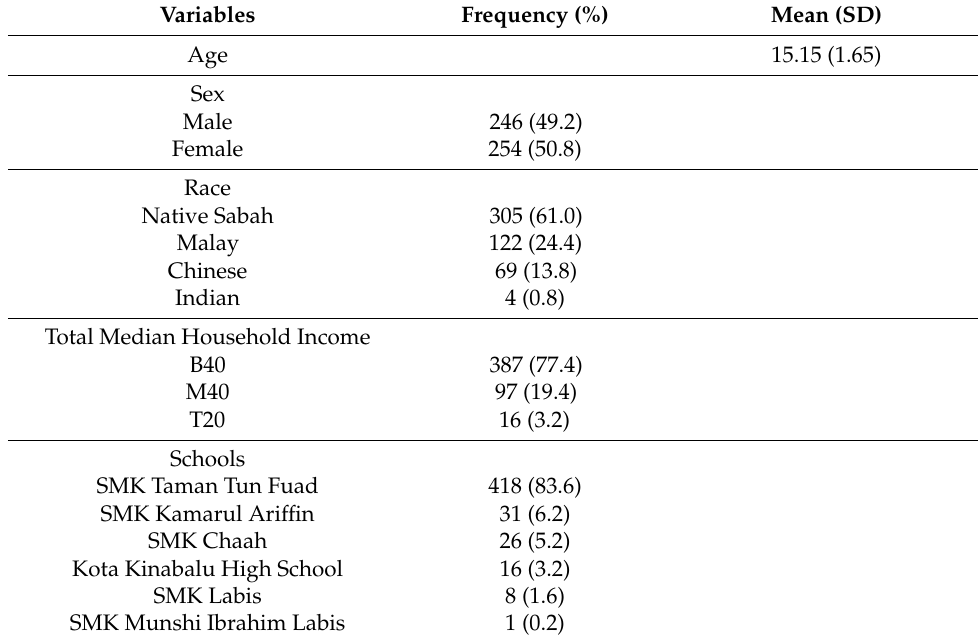
Table 3. Participants’ sociodemographic profile.